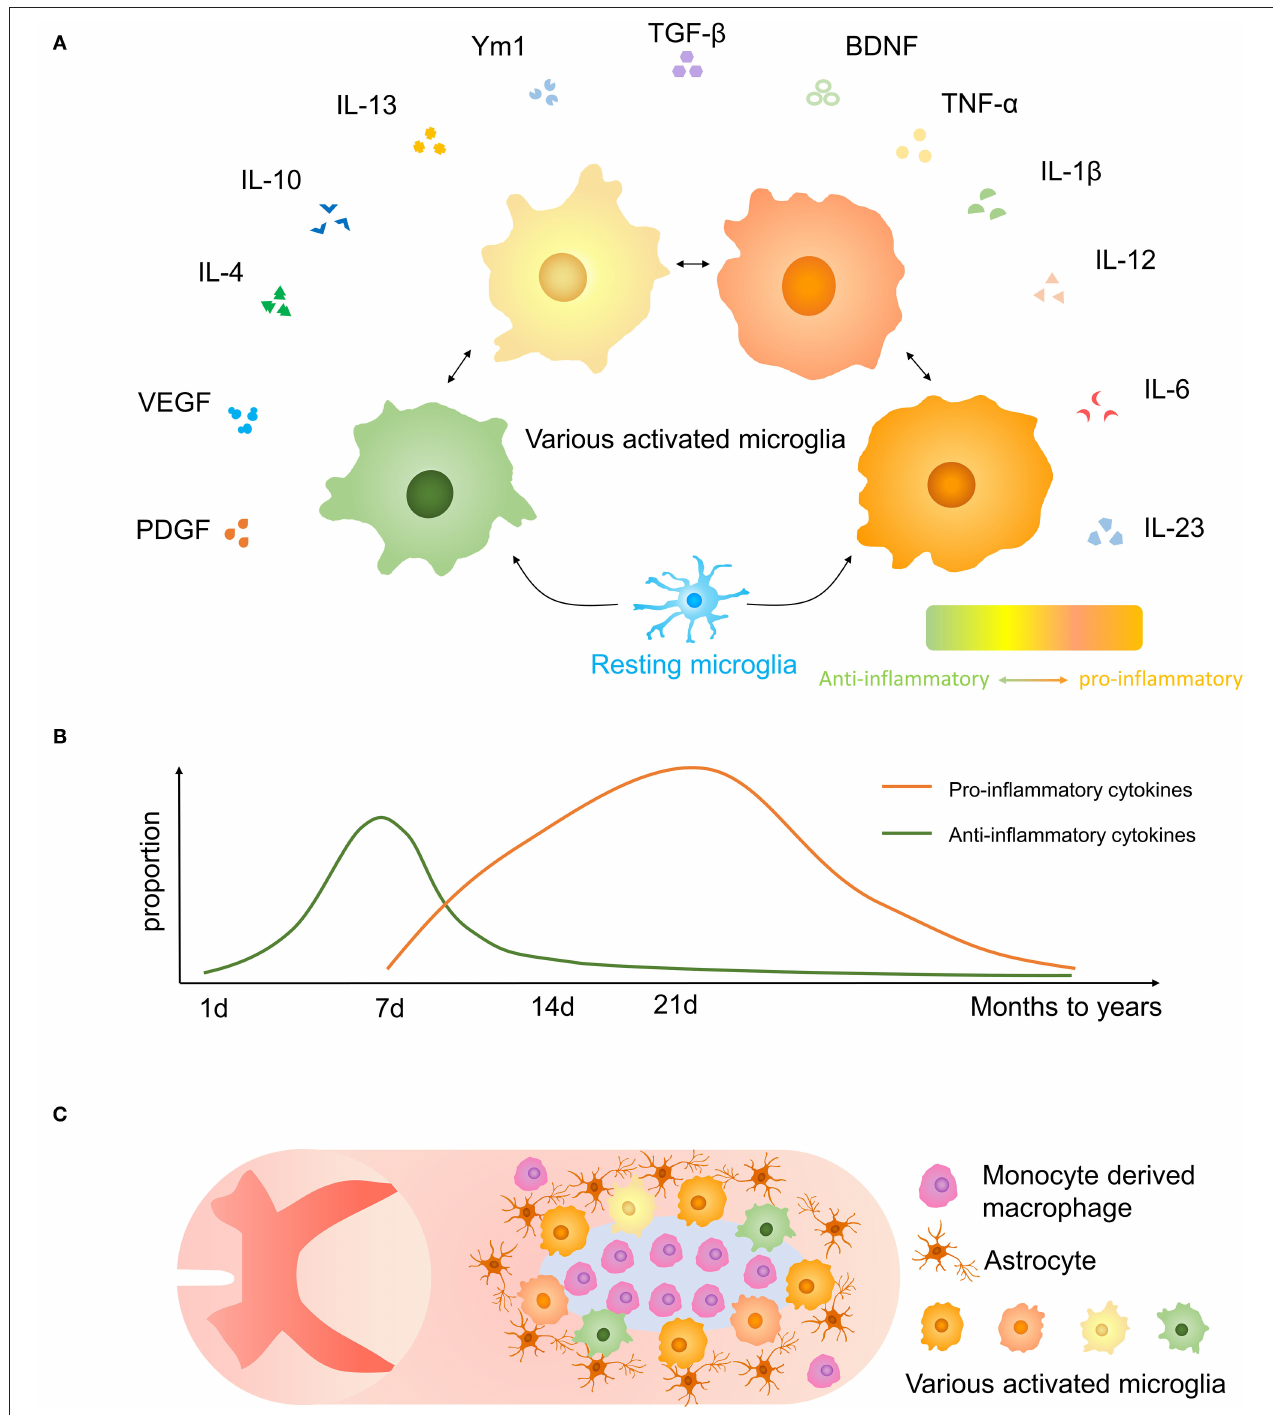
FIGURE 3 | Microglial polarization after traumatic SCI. (A) Secretory functions of various activated microglia. (B) Anti-inflammatory molecules are prominent at 1-week post-injury, and proinflammatory effects are increased after 1 week and persist for months to years. (C) The distribution of microglia and other cells and glial scar in the injured spinal